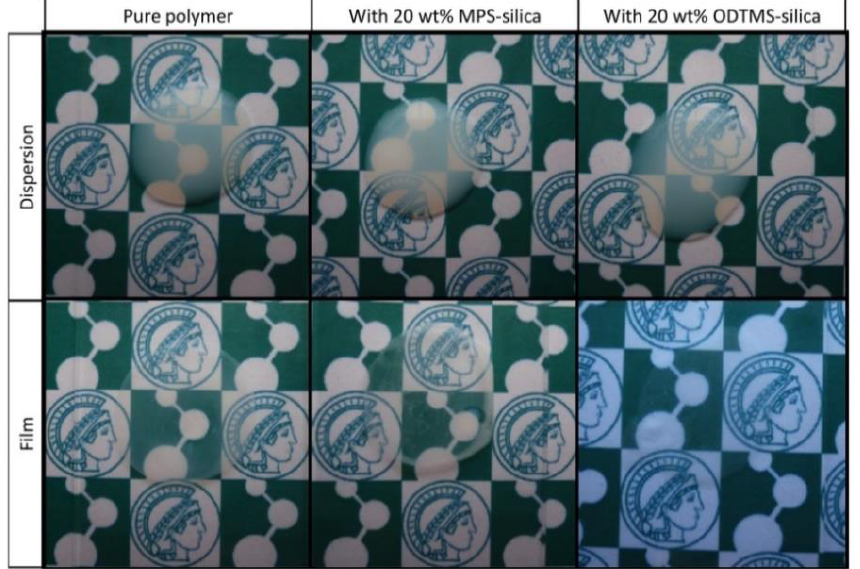
Figure 6. Dispersions ( top ) and the corresponding films annealing at 100 °C for 24 h ( bottom ) obtained using BMA:MMA (butyl methacrylate:methyl methacrylate) nanoparticles without silica (pure polymer), with 20 wt% of silica nanoparticles (SNPs) modified with MPS, and with 20 wt% of SNPs modified with ODTMS (N-octadecyltrimethoxysilane). Reprinted with permission from ref. [89]. Copyright 2016 John Wiley and Sons.